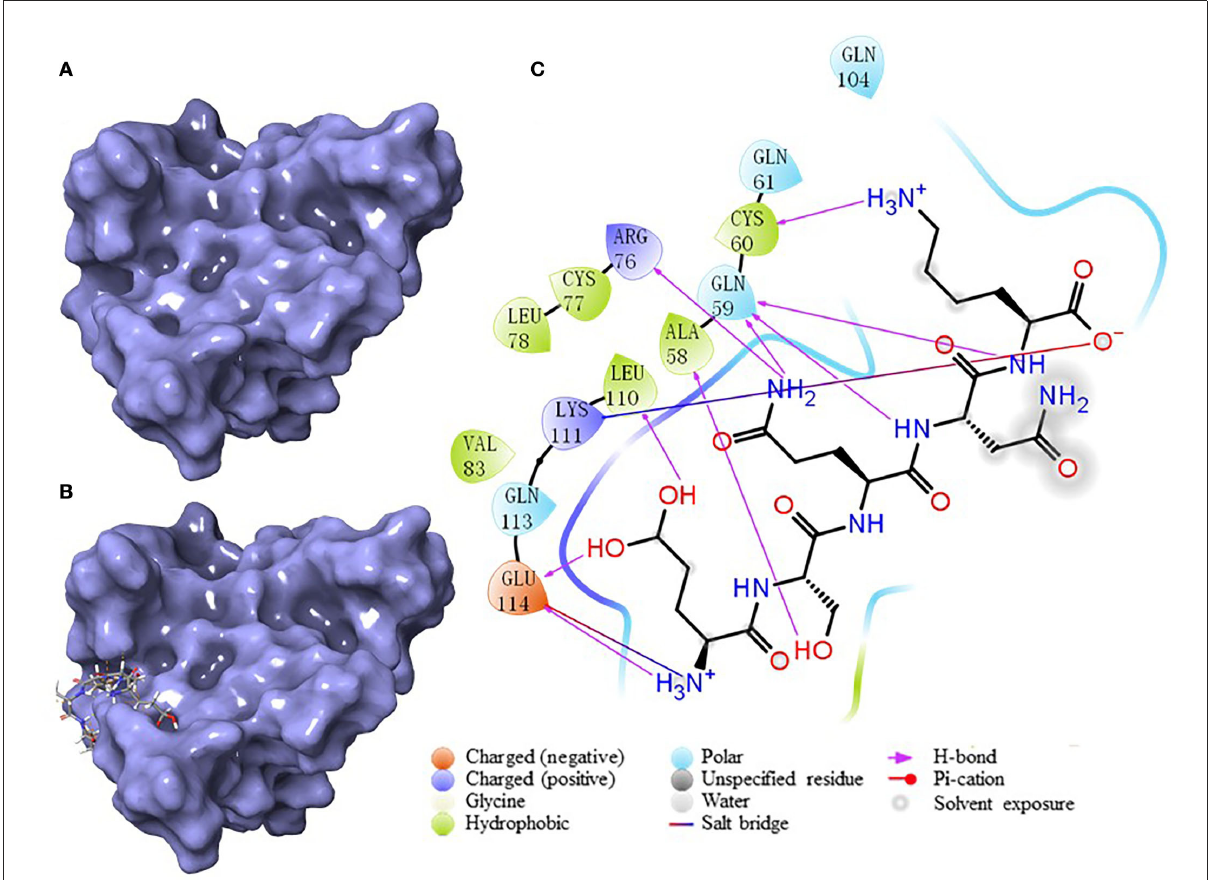
FIGURE7 The results of molecular docking. (A) The crystal structure of AKT (PDB: 1UNQ). (B) The binding site location of the composite structure. (C) The interaction between ligand (ESQNK) and the receptor